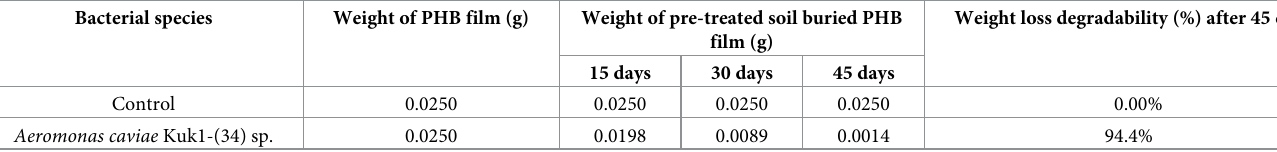
Table 12. Weight loss degradability of PHB film after different incubation time in optimised conditions. Bacterial